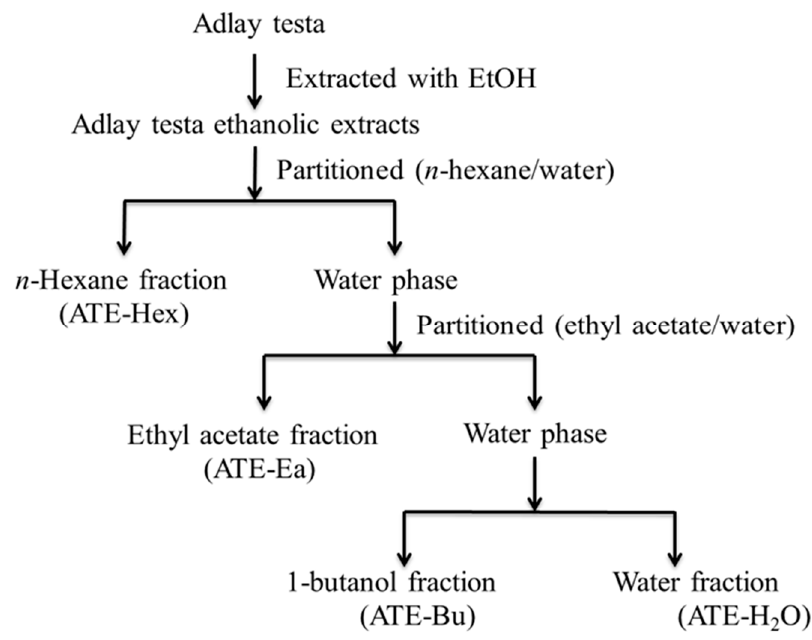
Figure 8. Extraction and partition scheme of adlay testa ethanolic extract (ATE).